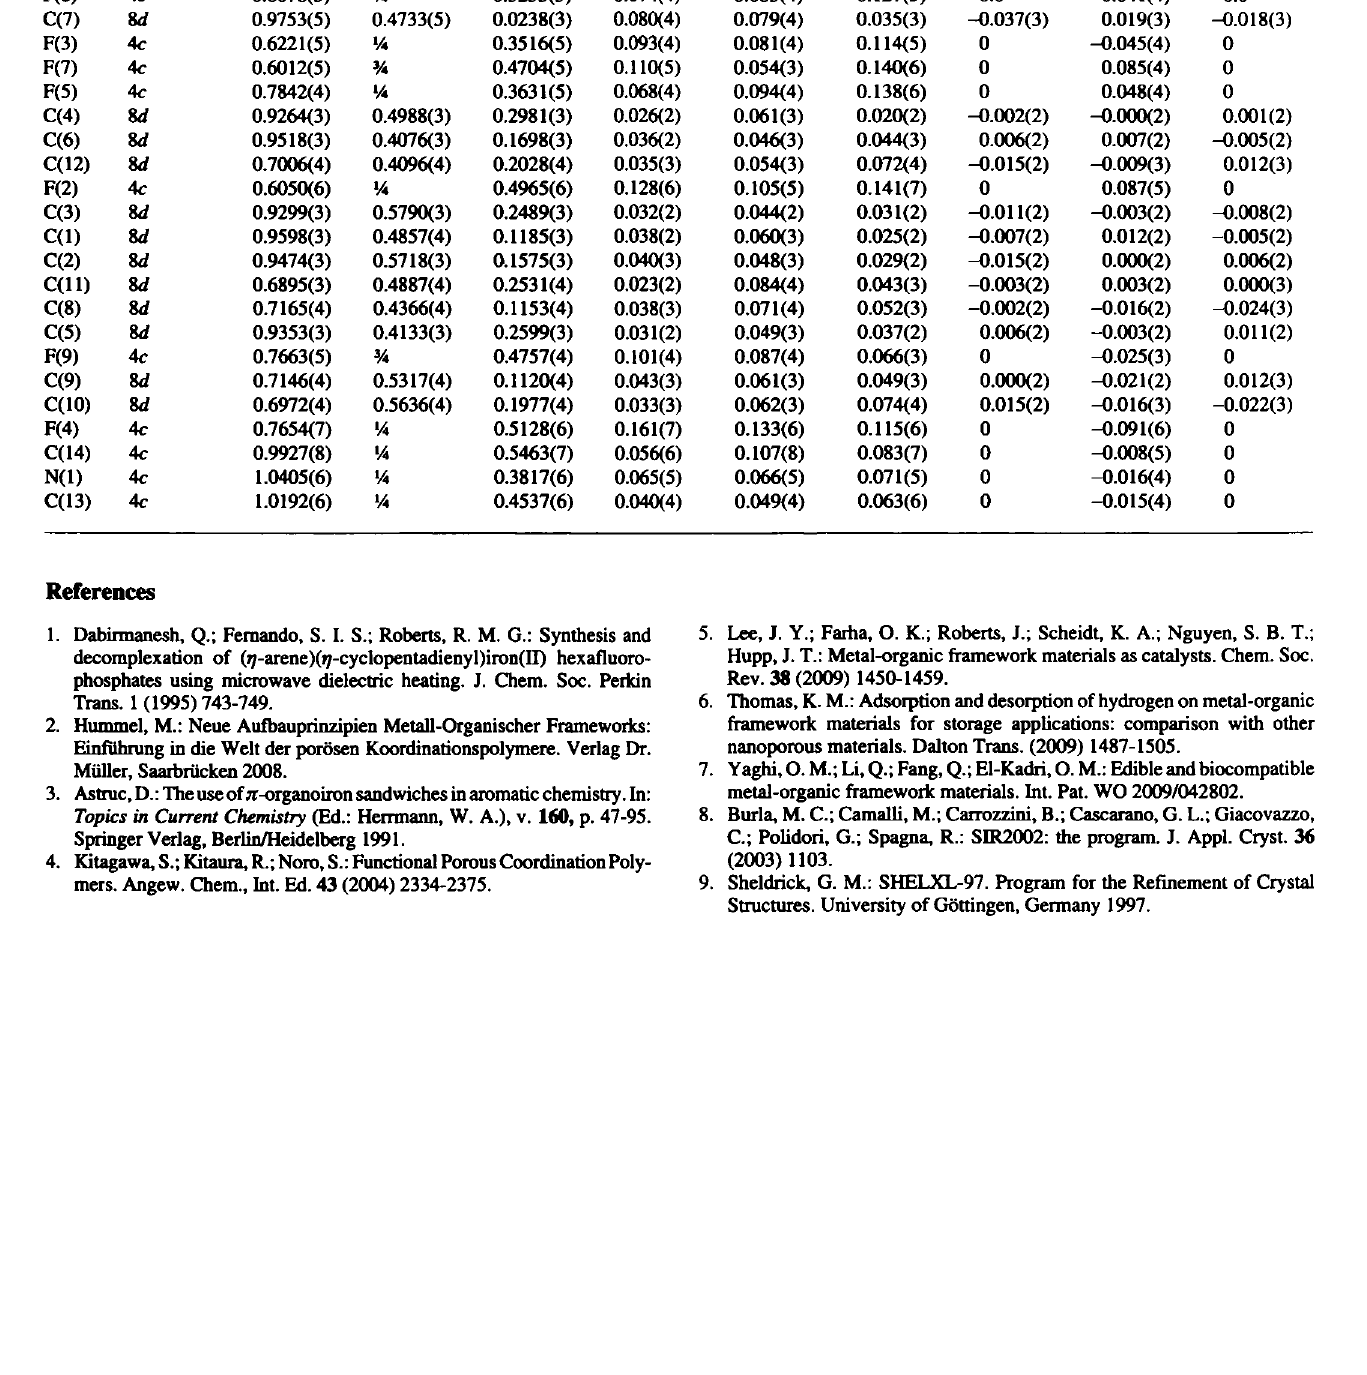
Table 3. Atomic coordinates and displacement parameters (in À 2